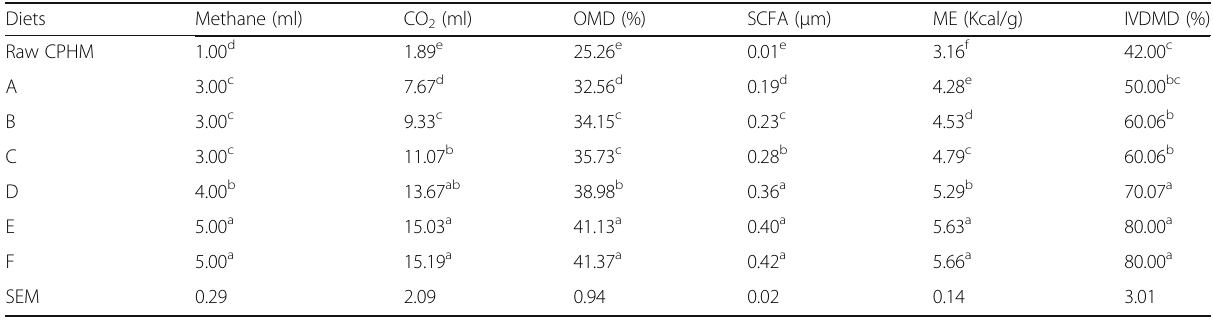
Means on the same row with different superscript letters are significantly ( p < 0.05) different OMD organic matter digestibility, CO 2 (carbon dioxide) gas production from insoluble fraction, SCFA short-chain fatty acid, ME metabolizable energy, IVDMD in